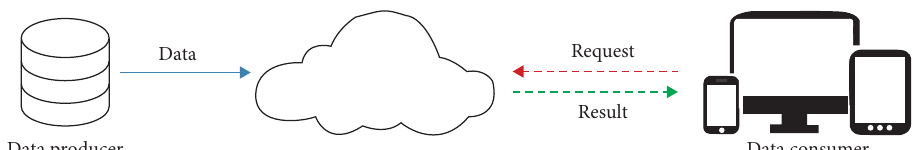
Figure 1: Structure of cloud computing [2].